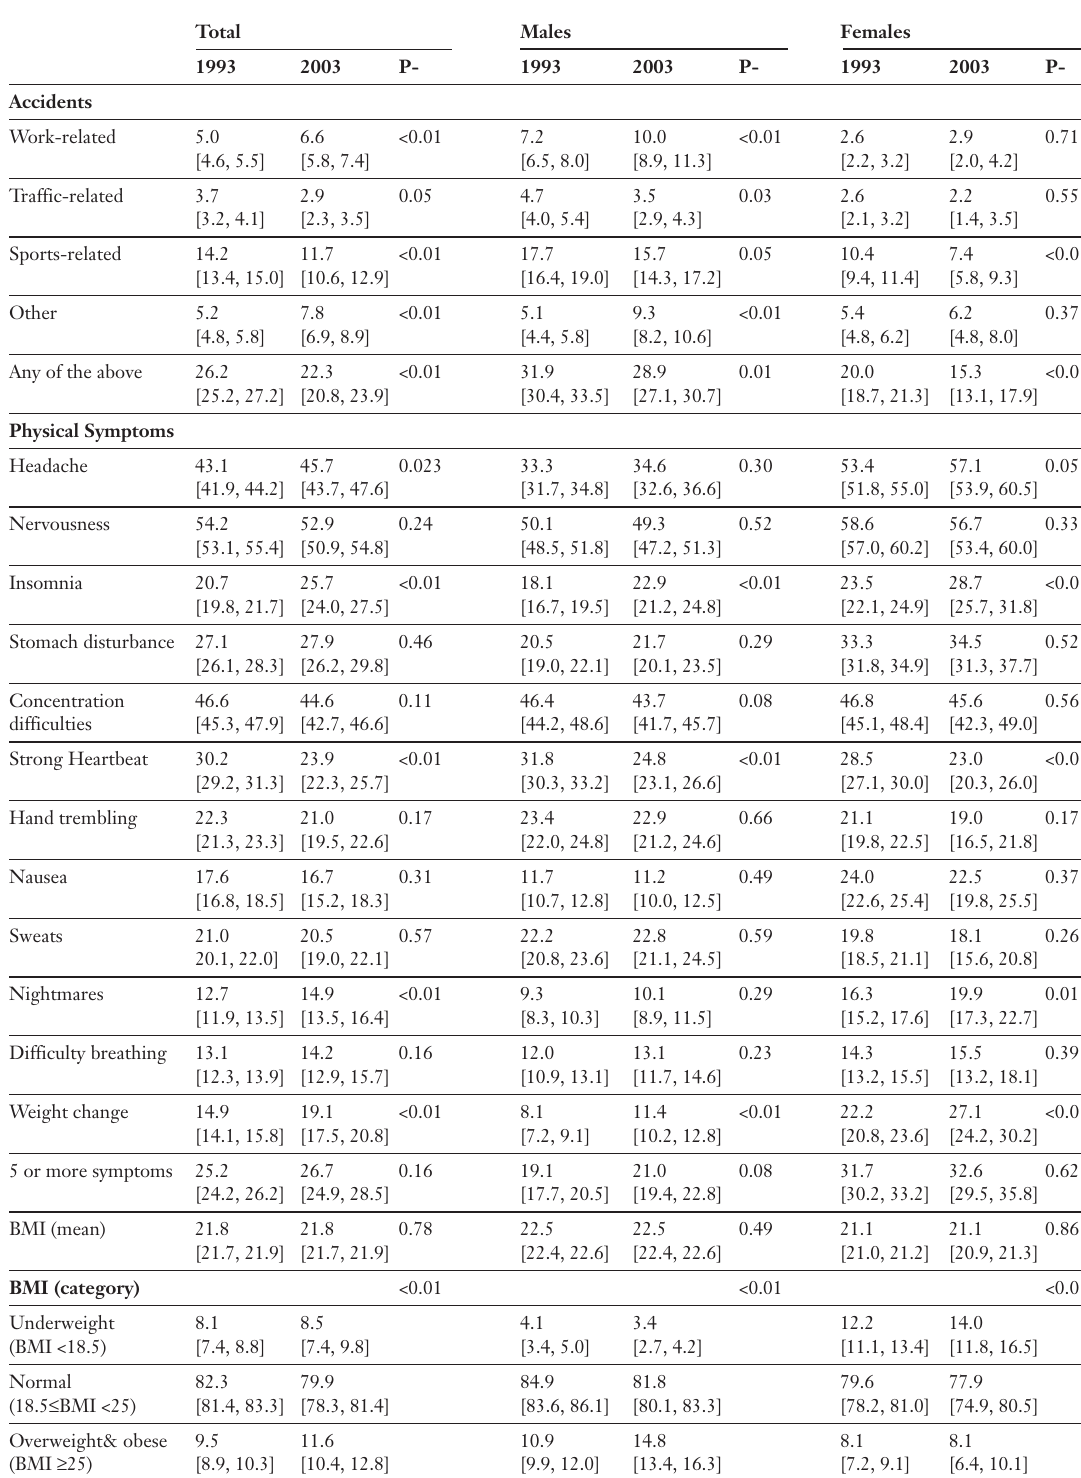
Table 2 Differences in Health- related Outcomes be- tween 1993 and